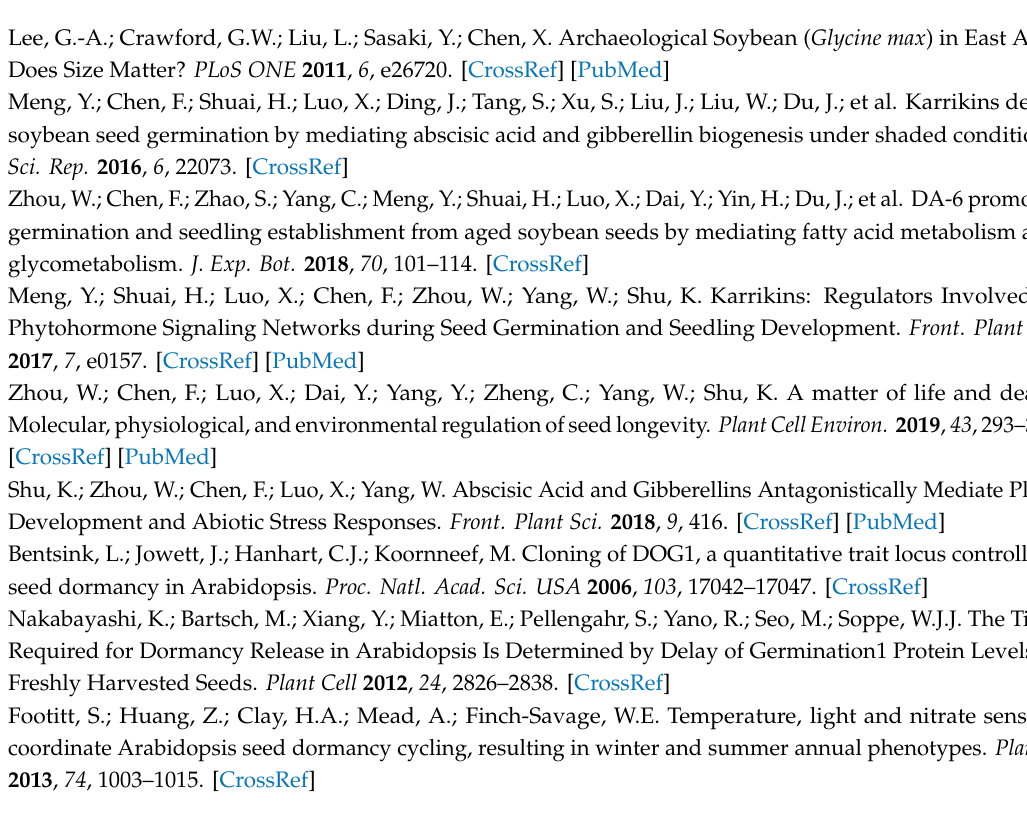
Figure S1: Phylogenetic analysis of DOG1Ls from soybean, Arabidopsis , Hordeum vulgare , Triticum aestivum and Oryza sativa , Figure S2: Phylogenetic analysis and exon-intron organization of DOG1Ls, Figure S3: Cis-acting element of GmDOG1Ls , Figure S4: Distribution of GmDOG1Ls on soybean chromosomes. Forty GmDOG1L genes were located in 18 chromosomes. The chromosome 9 and chromosome16 has no GmDOG1L genes, Figure S5: The syntenic relationships among GmDOG1Ls , Table S1: Gene Name and Gene ID of DOG1-Like in four species, Table S2: Information about the duplicated regions of GmDOG1Ls , Table S3: Duplication events of GmDOG1Ls , Table S4: Primers sequence used in this